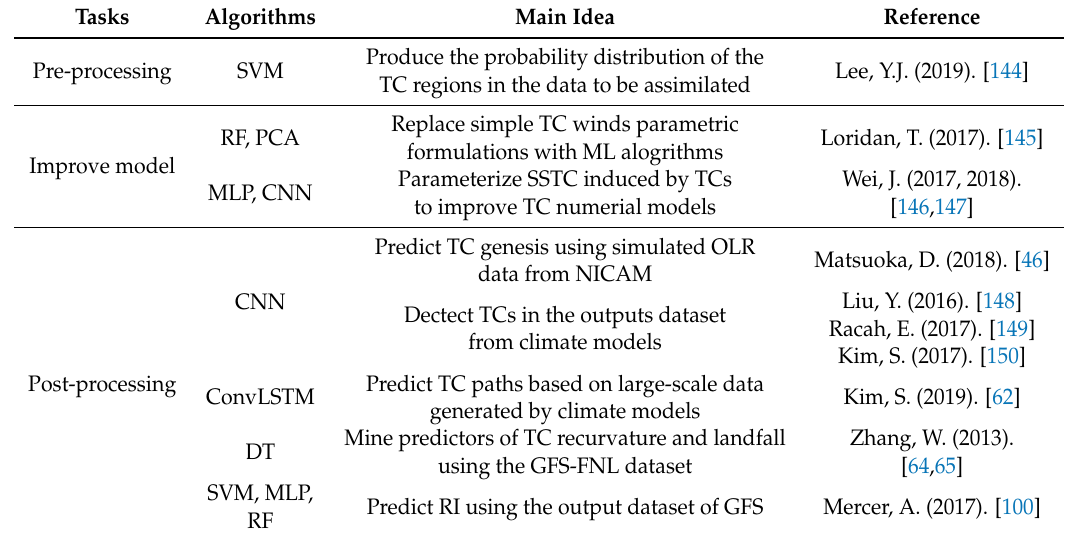
Table 5. Machine learning in improving numerical forecast